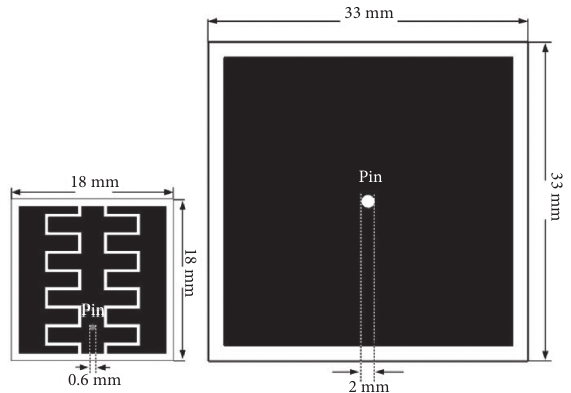
Figure 7: The dimension structure comparison between ICPW-EBG unit cell and M-EBG unit cell at